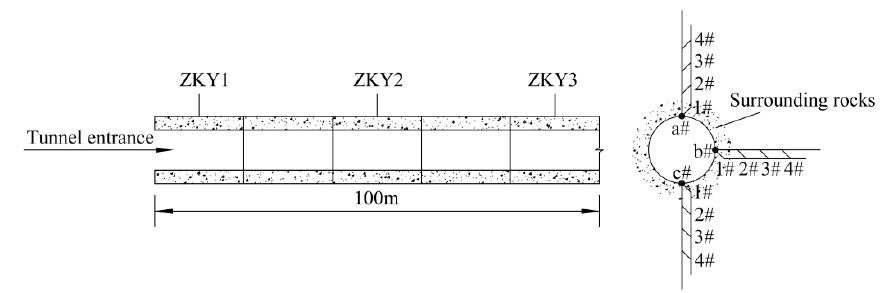
Figure 2. Layout of temperature stress measuring